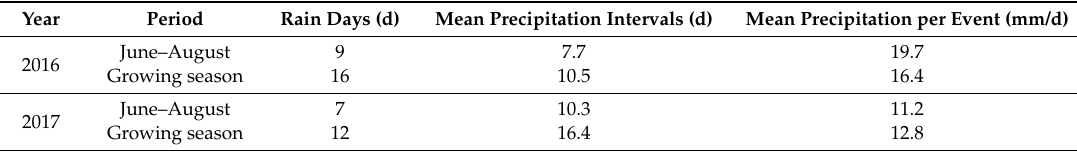
Table 2. Mean precipitation intervals in different precipitation years.